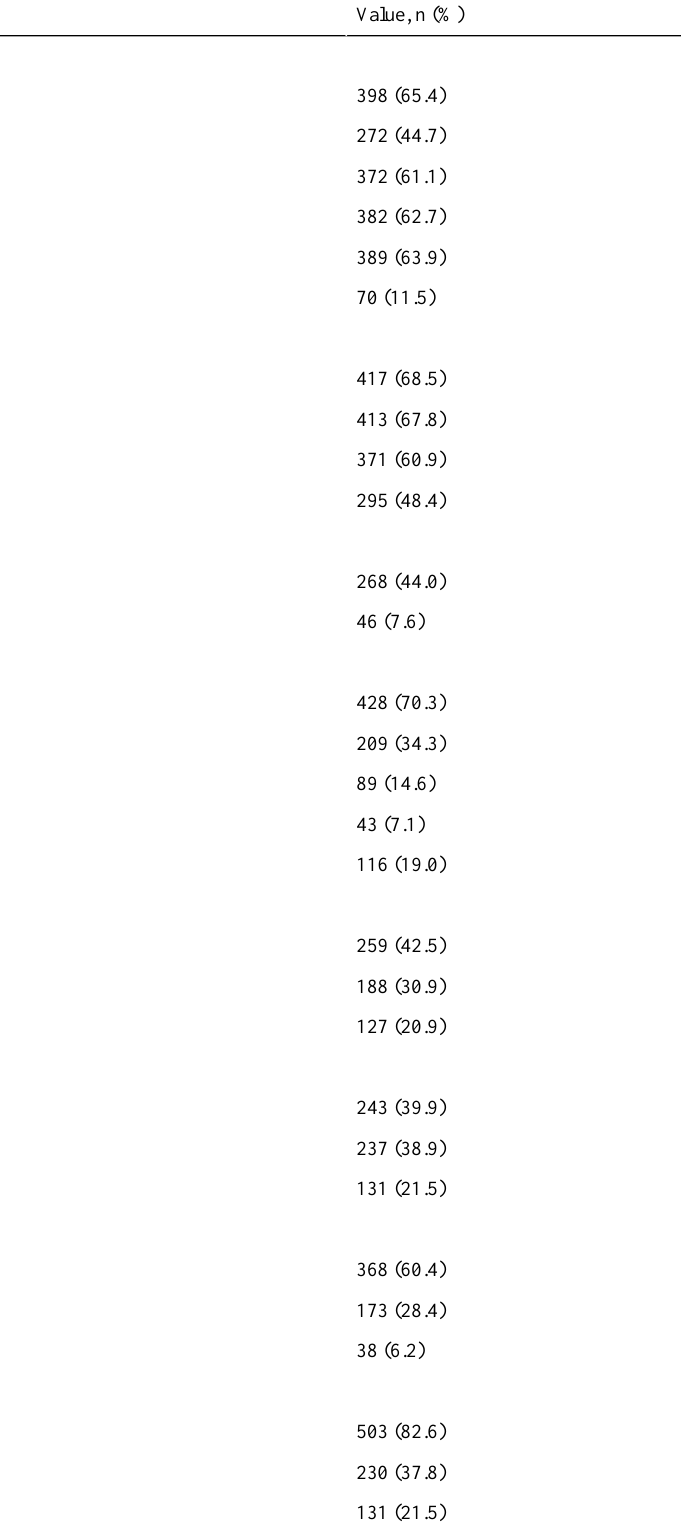
Table 2. Summary of answers to questions about data content and format and desired features